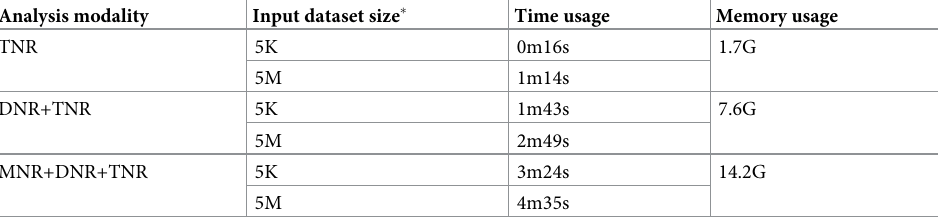
Table 3. Polytrap computational cost on example sessions. Sessions were tested on a Linux Ubuntu work station with Intel Xeon CUP E5-2650 V4 @ 2.20GHz and 32 GB